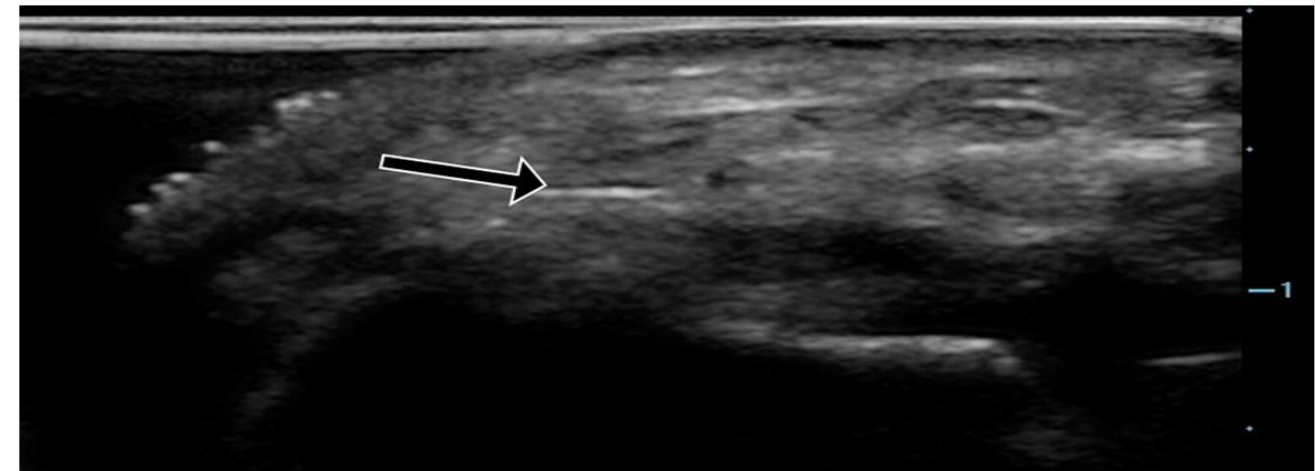
Figure 4c. Ultrasound of the radial artery showing complete collapse with pressure applied, representing systolic pressure (arrow).